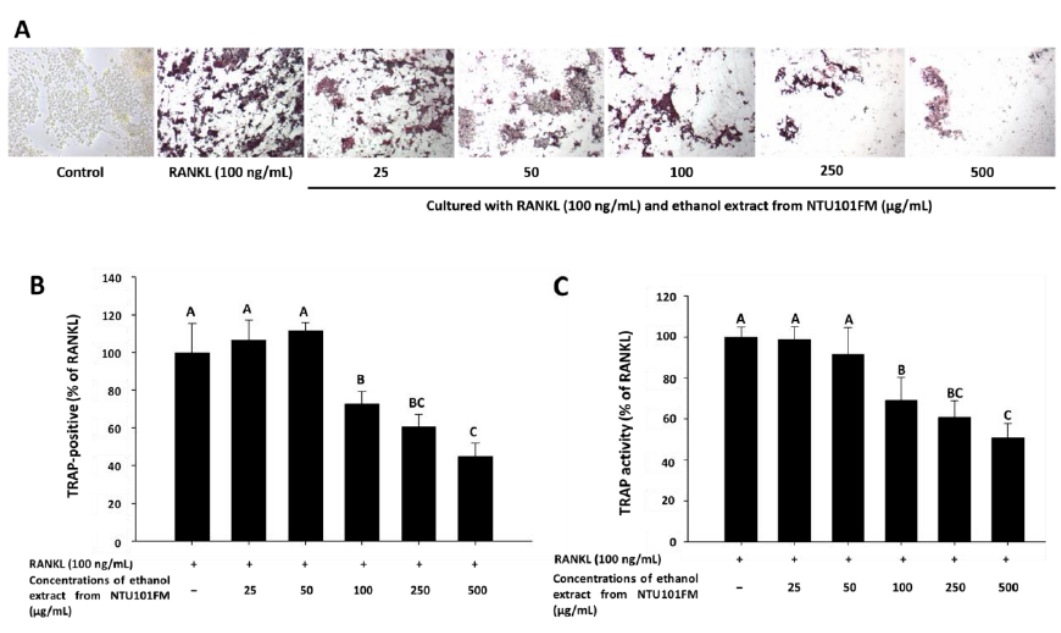
Figure 3. Effect of NTU101FM ethanol extract on RANKL-induced osteoclast differentiation: ( A ) photograph of TRAP-stained osteoclasts; ( B ) number of TRAP-positive multinucleated osteoclasts; and ( C ) TRAP activity. The RAW 264.7 cells were cultured with the indicated dose of NTU101FM ethanol extract (25 to 500 µ g/mL) in the presence of RANKL (100 ng/mL) for four days. The data are presented as means ± SD ( n = 3). Values with different uppercase letters were significant by Duncan’s multiple range tests ( p < 0.05). NTU101FM, NTU 101-fermented skim milk; RANKL, receptor activator of nuclear factor kappa- β ligand; TRAP, tartrate-resistant acid